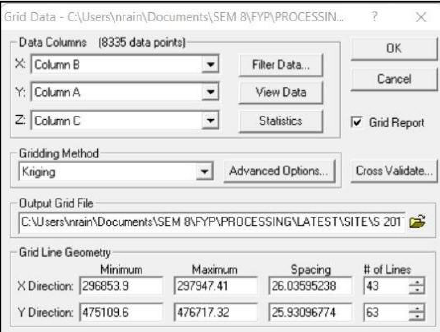
Figure 6. The interface of Grid Data Setting